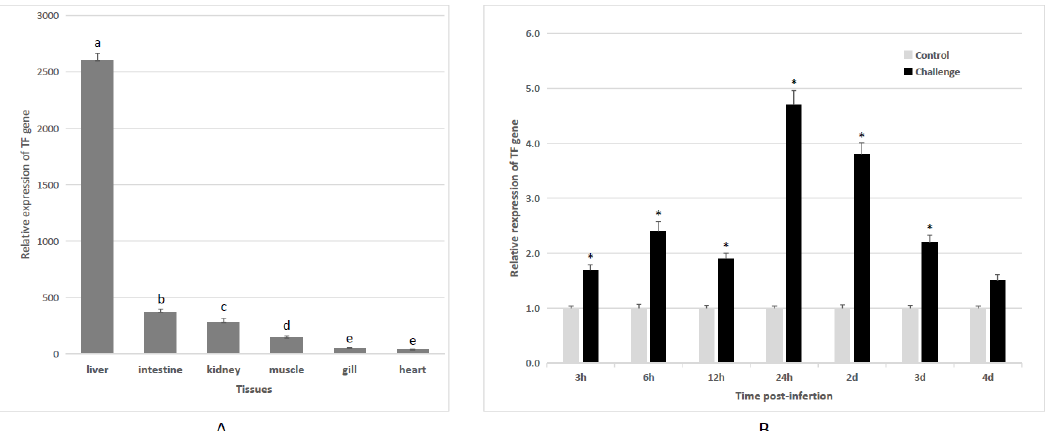
Figure 2. Expression patterns of TF gene in P. sinensis . ( A ) Relative expression level of the TF gene in six healthy tissues of P. sinensis (liver, intestine, kidney, muscle, gill, and heart) by qRT-PCR. Different letters indicated statistical significance at the level of p < 0.05. Values were described as mean ± SE ( n = 3). ( B ) Relative expression pattern of the P. sinensis TF gene in the liver after Strepto- coccus iniae infection by qRT-PCR. Values were described as mean ± SE ( n = 3). The asterisks indi- cated statistically significant differences from the control group (* p < 0.05).